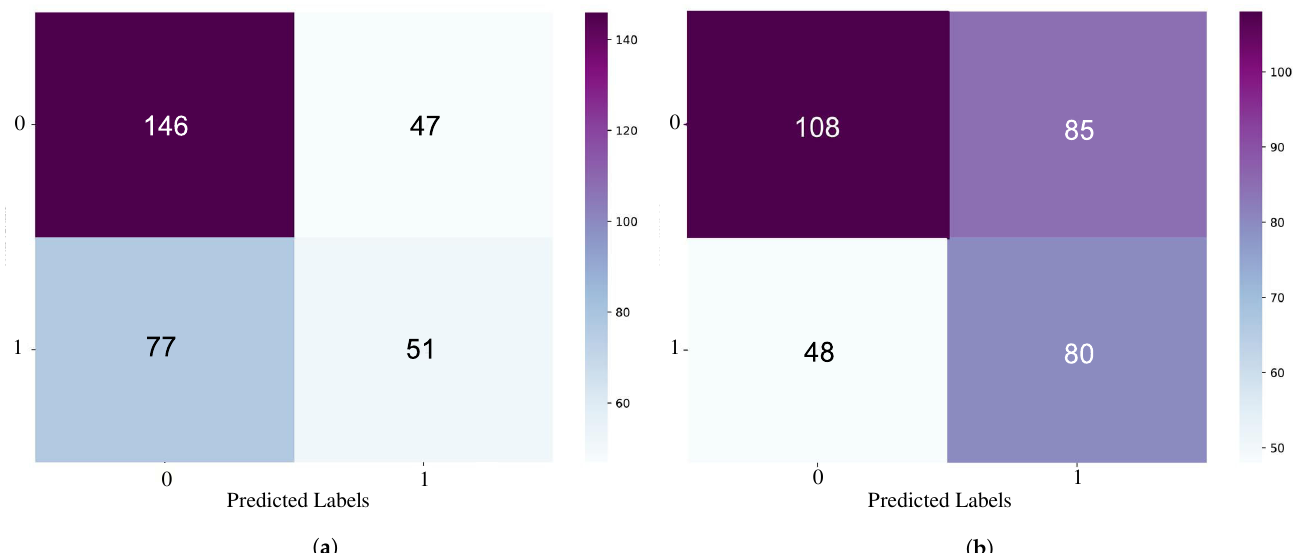
Figure 10. The heatmap representation of the confusion matrix of the best models obtained from using the MFCCs alone ( a ) and using the combination of all spectral features ( b